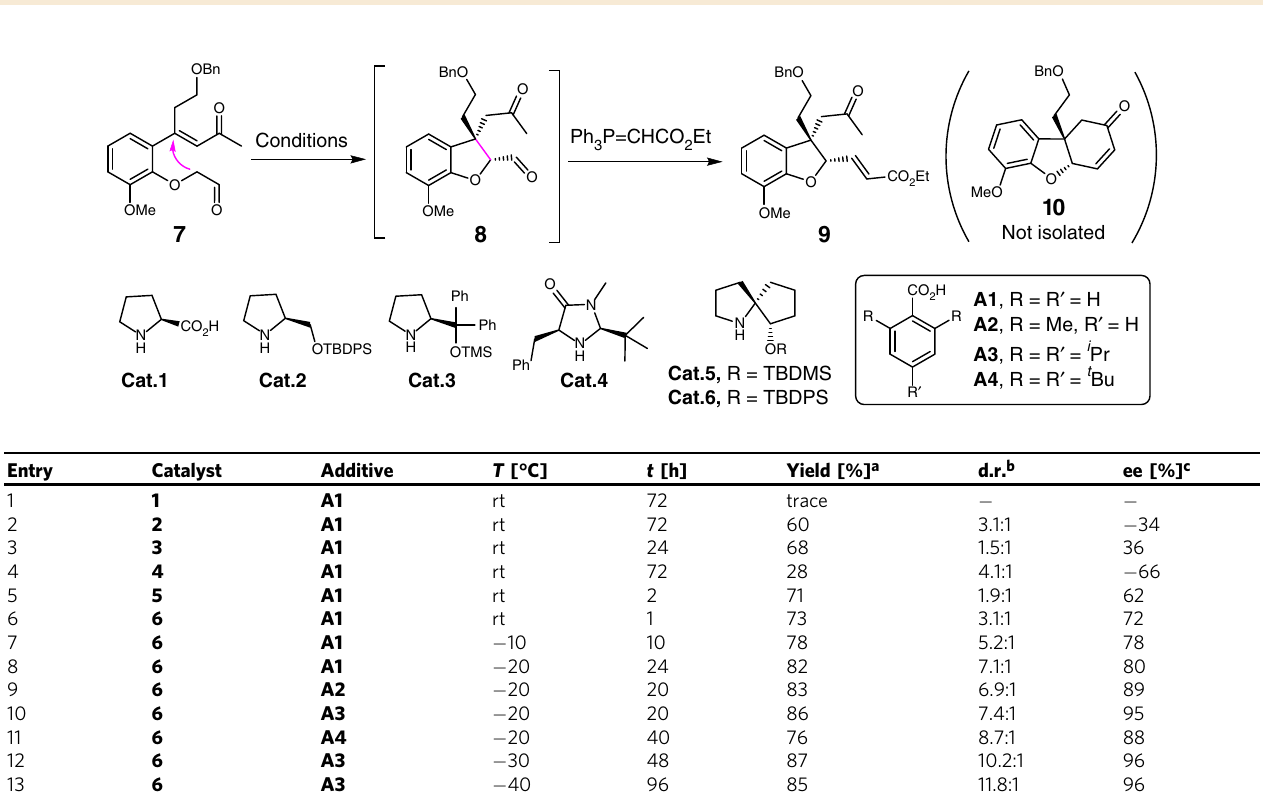
Table 1 The optimization of intramolecular Michael addition/Wittig